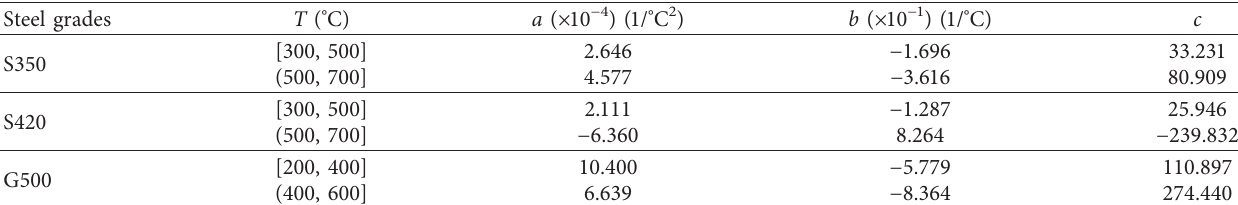
Table 11: Constants for Ramberg–Osgood hardening